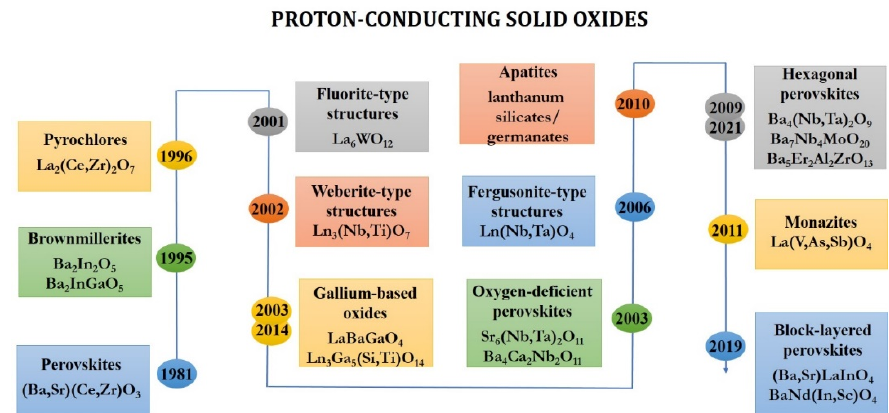
Figure 1. Historical overview on the development of proton-conducting solid oxides.